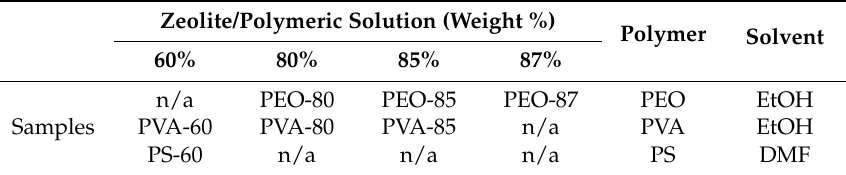
Table 1. Precursor mixtures